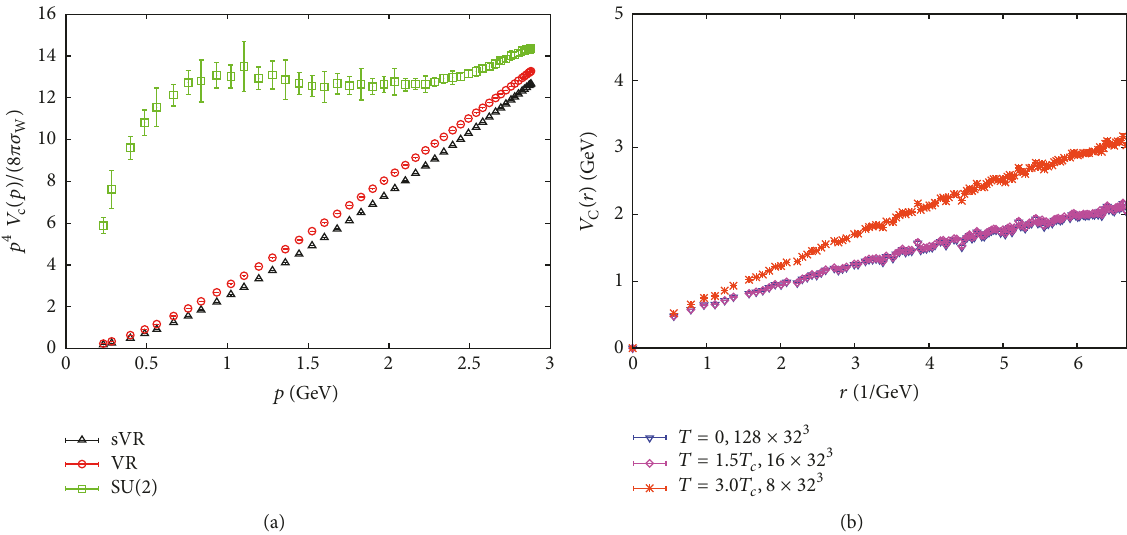
Figure 11: (a) Non-Abelian Coulomb potential in momentum space (green boxes) compared to the result obtained after removing just the spatial (black triangles) or all center vortices (red circles). (b) Non-Abelian Coulomb potential for different temperatures ( 𝑇 푐 denotes the critical